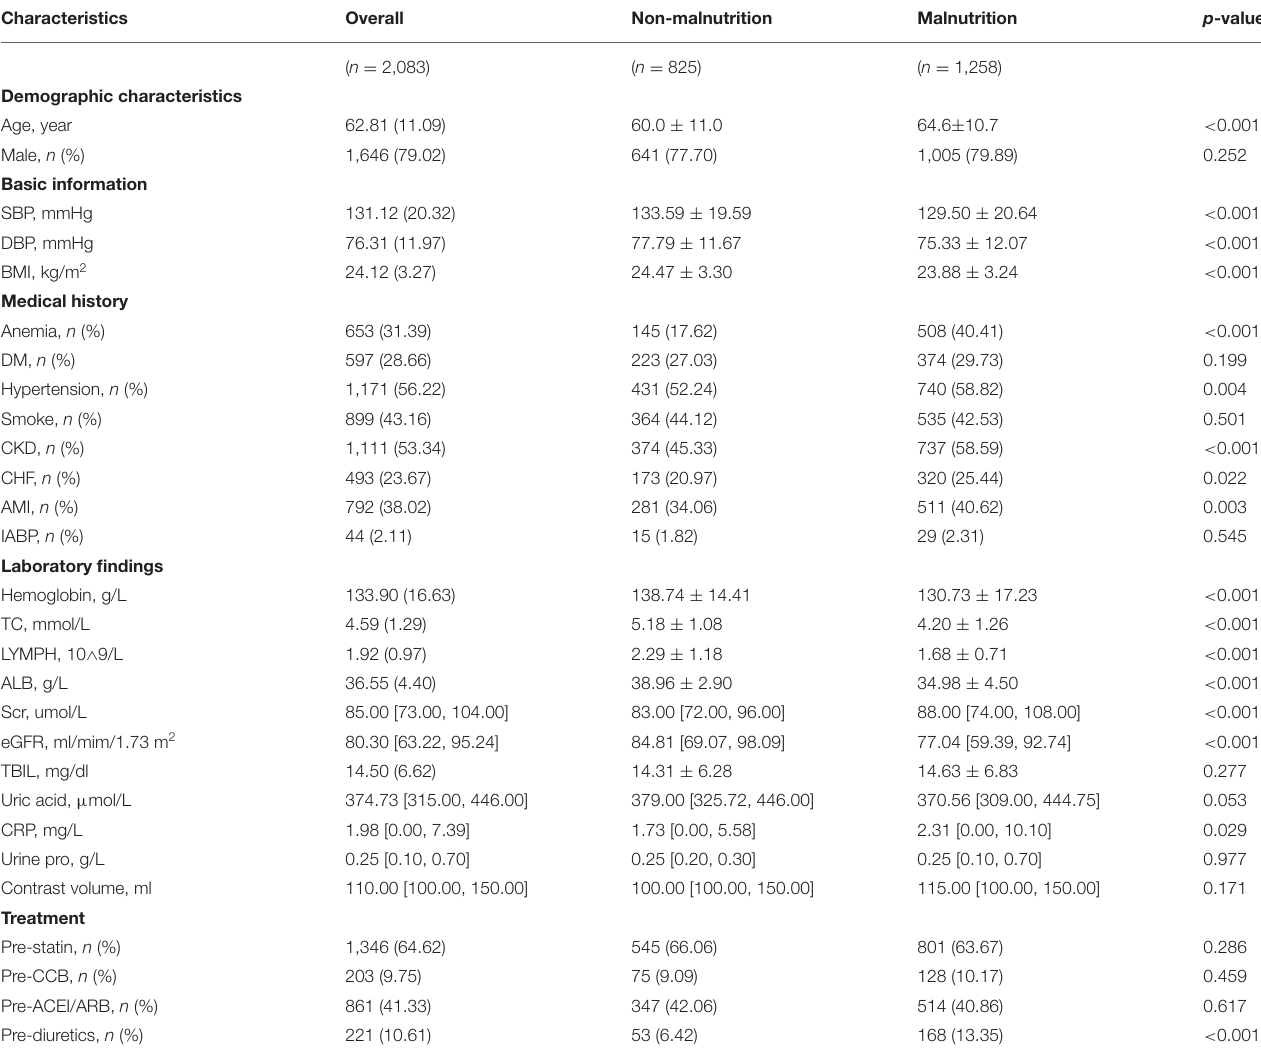
TABLE 1 | Baseline characteristics stratified by risk of malnutrition (Cut-off value based on a traditional threshold). Characteristics Overall